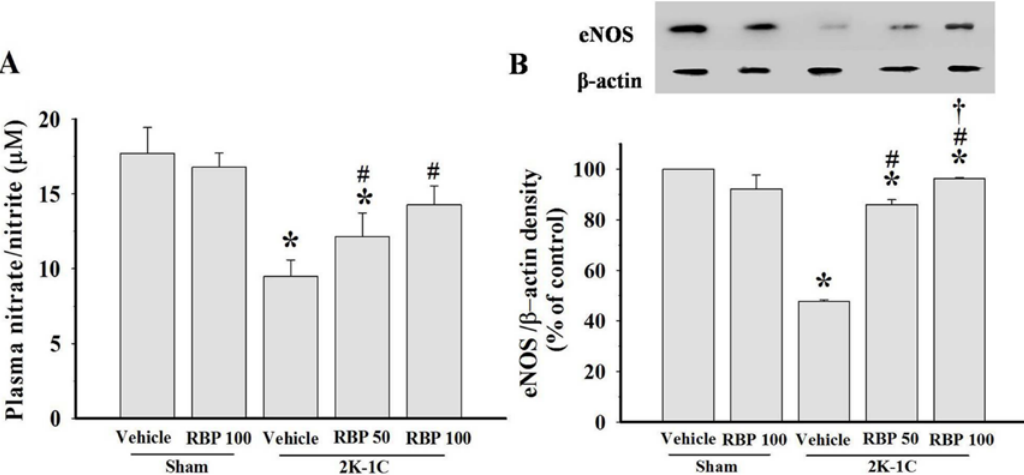
Figure 4. Plasma nitrate/nitrite levels ( A ) and eNOS protein expression and densitometric analysis in thoracic aortas ( B ) in all experimental groups. Data are mean values ± SEM. ( n = 8/group), * p < 0.05 vs. sham-operated group, # p < 0.05 vs. 2K-1C group and † p < 0.05 vs. 2K-1C + RBP50 group. Rice bran peptides, RBP.